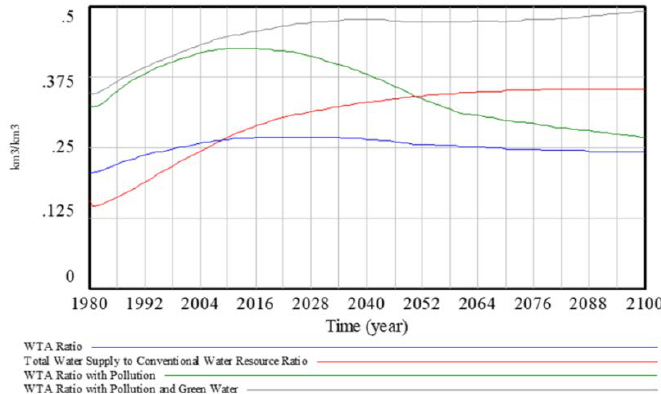
Figure 6. ANEMI3 simulated levels of water stress using the withdrawal to availability ratio and alternate formulations.